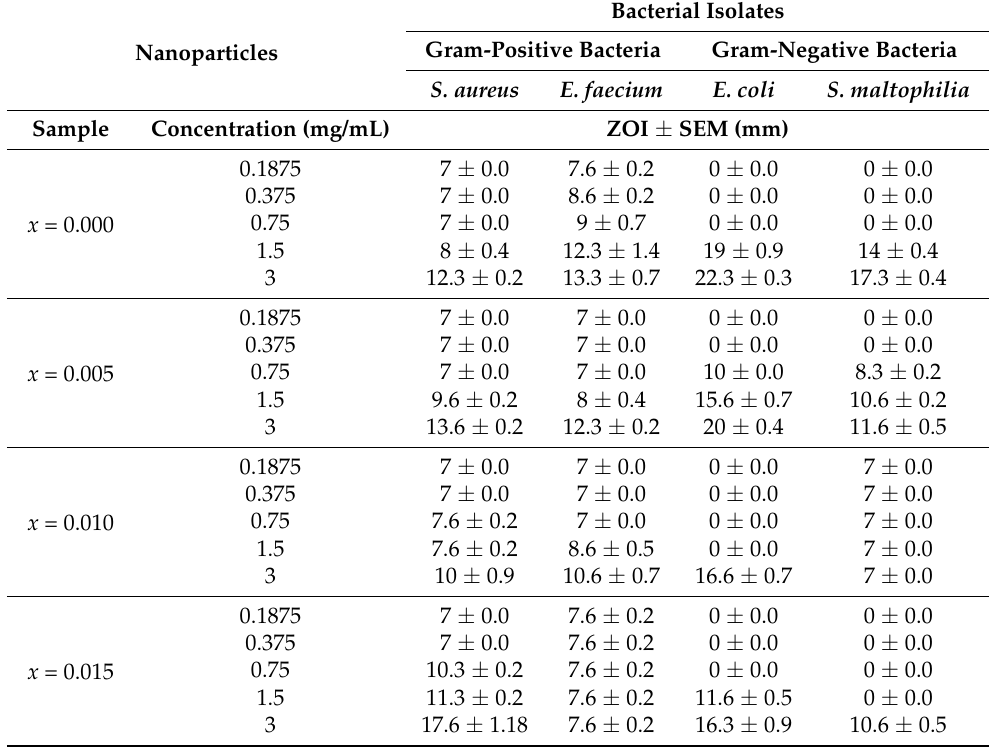
Table 3. Agar well diffusion of undoped and Mg-doped CuO NPs against four bacterial isolates. Bacterial Isolates Gram-Positive Nanoparticles